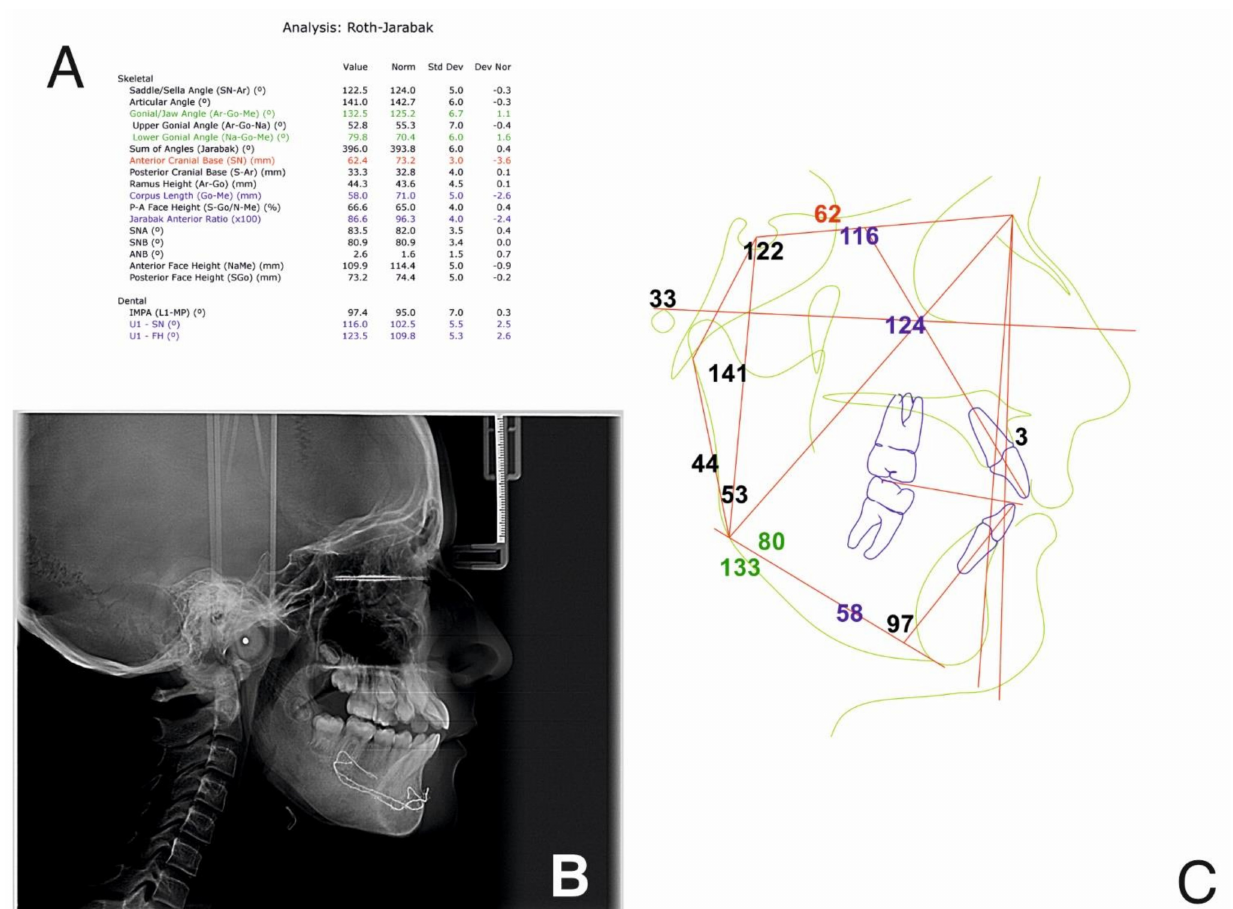
Figure 16. Post-splint therapy evaluation—cephalometric analysis: Roth Jarabak cephalometric analysis ( A ), cephalometric radiograph ( B ), landmarks and reference lines of the cephalometric analysis ( C